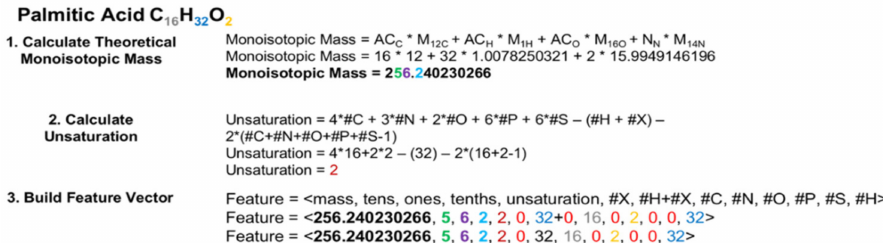
Figure 2. Example construction of a feature vector for the elemental molecular formula (EMF) C 16 H 32 O 2 , corresponding to palmitic acid. In a real-world application, the elemental molecular formula (EMF) would be provided from an assignment method, such as SMIRFE, and the compound it represents may not be known. The first step in constructing the feature vector is to calculate the theoretical monoisotopic mass for that EMF from the atom count for an element X (AC x ) and the mass of its most naturally abundant isotope (M x ). Calculating the theoretical mass for an EMF rather than relying upon the observed mass for the corresponding spectral feature eliminates the potential confound of mass error at the classification step. Calculating and using the monoisotopic mass is necessary so that isotopologues of the same EMF can be classified using the same classifiers. In the second step, the number of hydrogens missing in the formula due to unsaturation is calculated. Finally, the monoisotopic mass, the number of missing hydrogens, and the EMF are used to construct the feature vector. The coloring and bolding of the numbers in the example feature vector reflect the sources of these